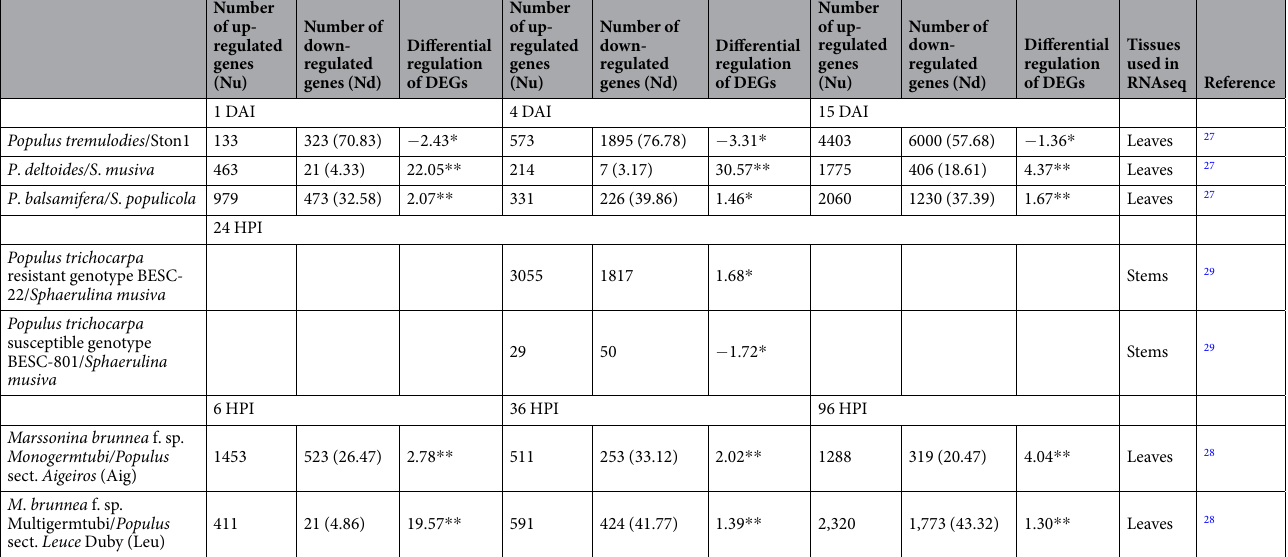
Table 5. DEGs number in fungal pathogen-infected plants. Notation: The negative values in this table represent the differential expressed genes (DEGs) are mainly down-regulated in this pathogen-plant interaction, while the positive values represent the DEGs are mainly up-regulated. Asterisks indicate the differential regulation of DEGs are significantly difference (the Chi-square test, the null hypothesis is Nd = Nu; * P < 0.05; ** P <